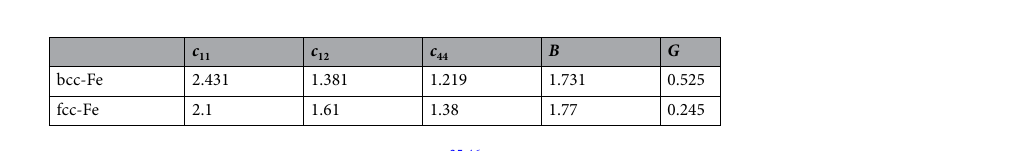
Table 1. Elastic stiffness tensor components 25,46 , bulk modulus B , and the shear modulus G in the unit of Mbar (10 11 N/m 2 ) for bcc-Fe and